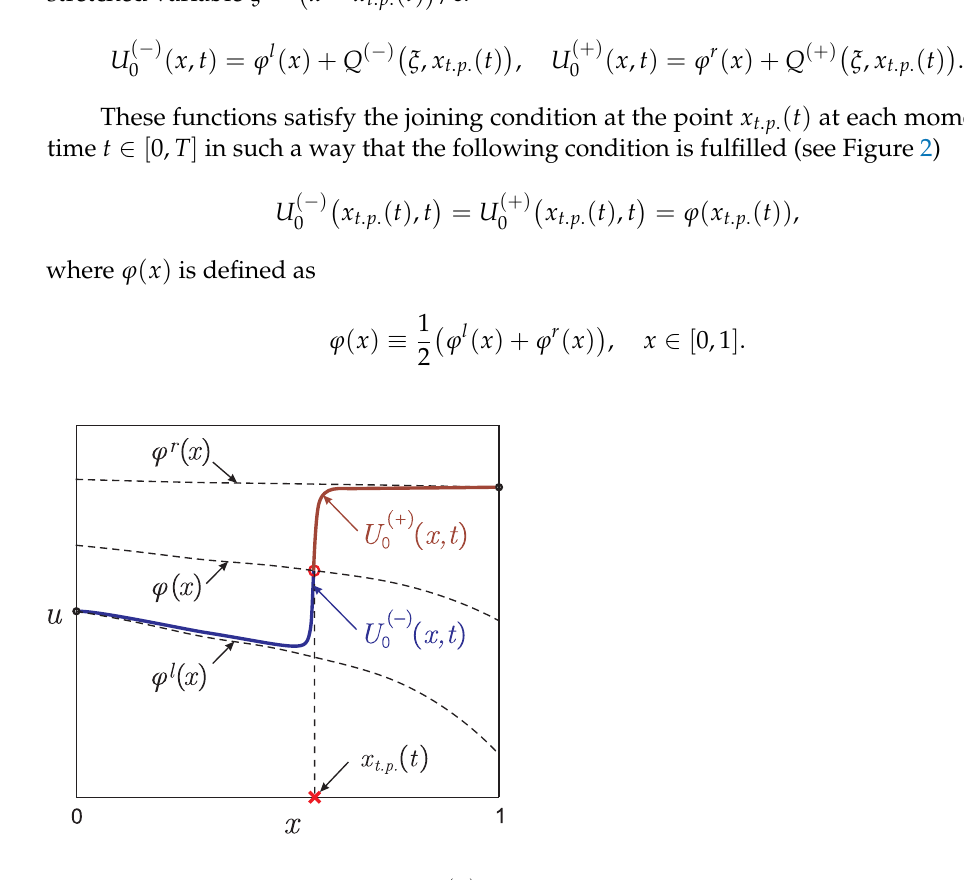
Figure 2. Relationship of the functions U front x t . p . ( t )